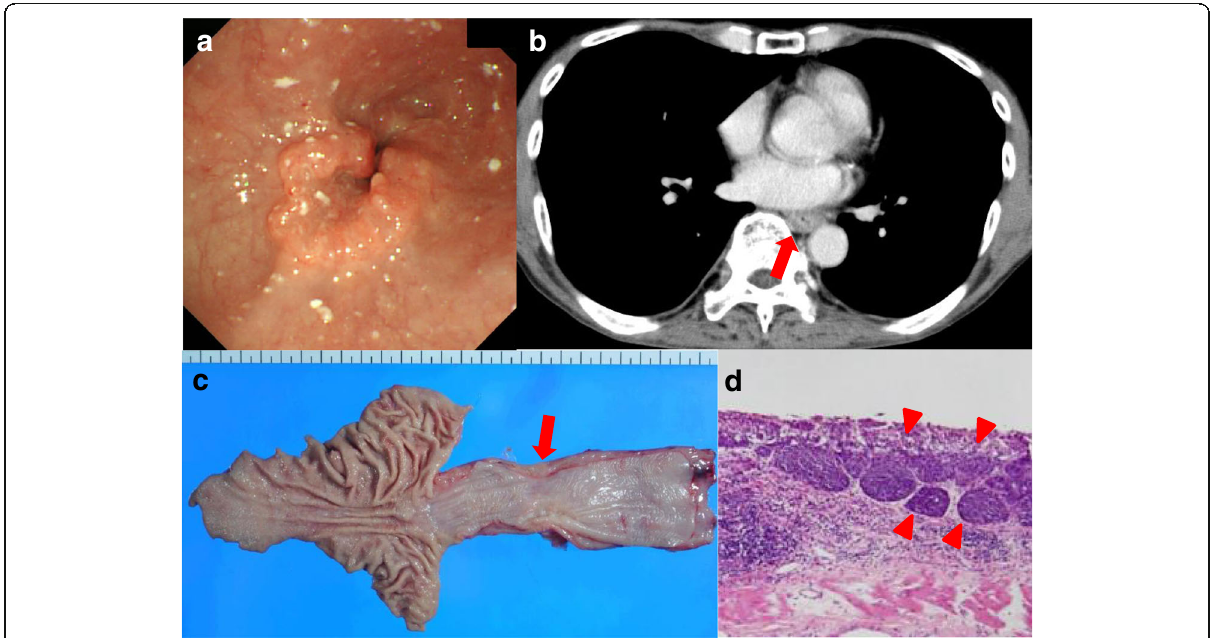
Fig. 1 Image findings before intervention and macroscopic and microscopic findings of resected specimen. a The endoscopic finding of primary esophageal cancer. Type 3 tumor with esophageal stenosis was located in the lower thoracic esophagus. b The preoperative CT image. The arrow indicates neoplastic lesion of the esophagus. c The resection specimen. The arrow indicates neoplastic lesion. d Hematoxylin-eosin staining of the resected specimen. The arrowheads indicate viable cancer cells within the mucosa of the